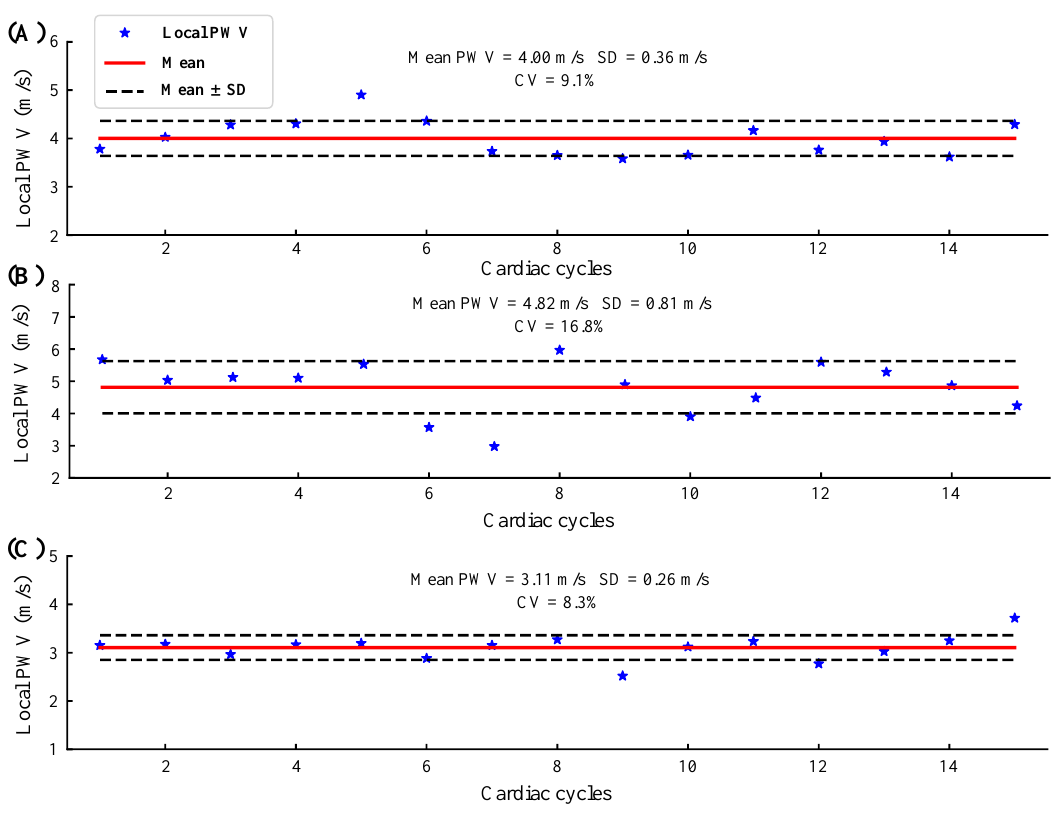
Figure 9. Beat-to-beat local PWV for 15 cardiac cycles of three subjects: ( A ) S1, Trial 1; ( B ) S4, Trial 2; ( C ) S5, Trial 2. Table 1. Statistical results of the local PWV measurements in five